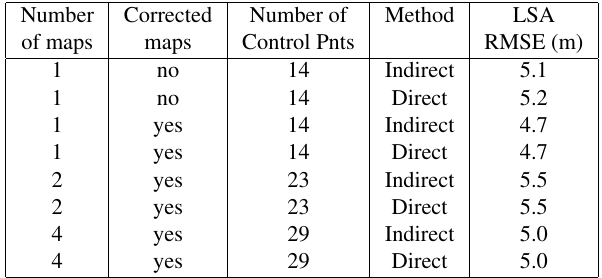
Table 1. The RMSE of all test cases in Attiki test site, computed using CPs (trigonometric points).